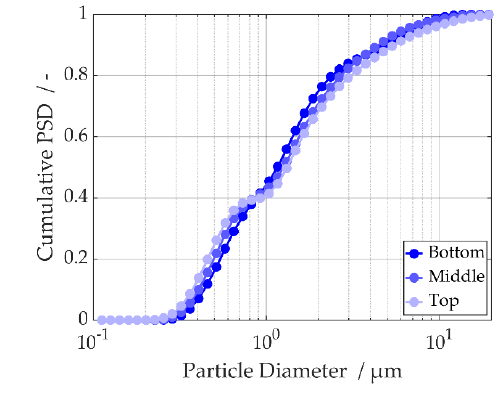
Figure 8. Centrate overall carbon content for the three cases over time. Blue: 20,000 rpm; Red: 40,000 rpm; Black: Increasing rotational speed. Squares: mean values; bars: Standard deviations; dashed lines are guides to the eye.